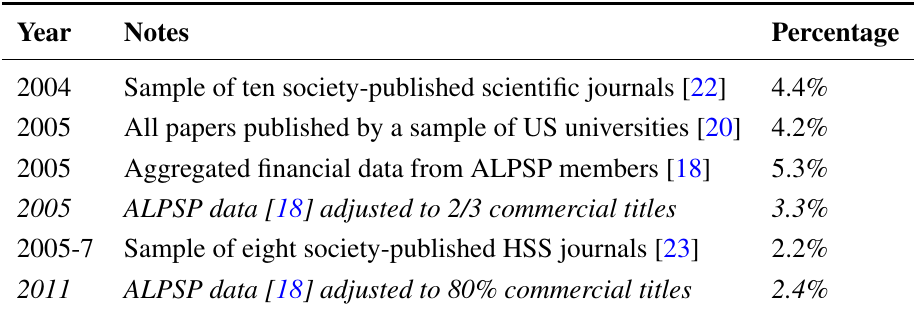
Table 1. Publication charges as a percentage of subscriptions in various